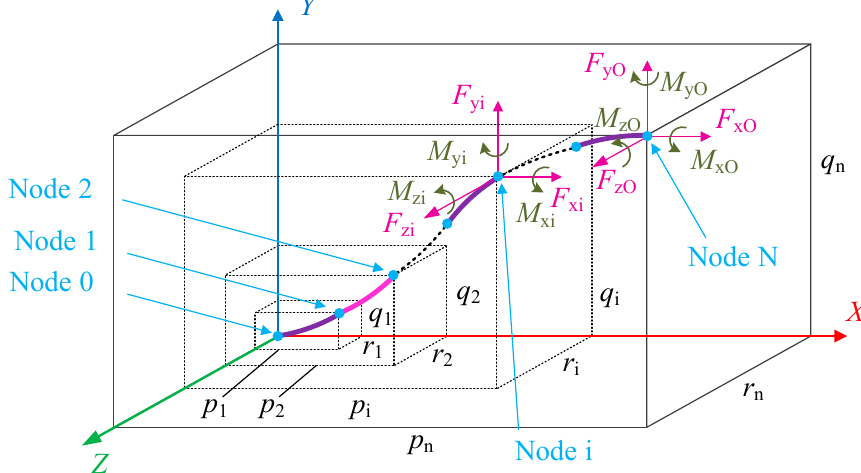
Figure 3. Chain model of the spatial FLS.